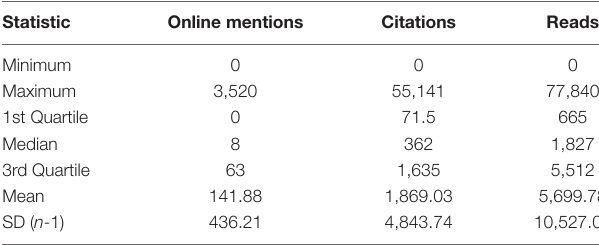
TaBle 2 | Author-level metrics descriptive